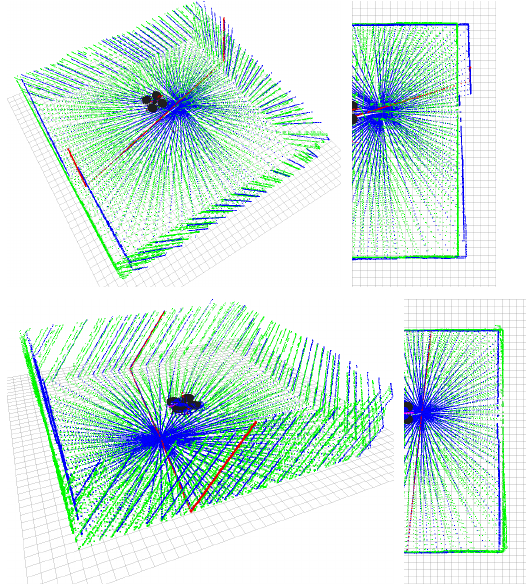
Figure 7: Sensor movement during scan acquisition yields dis- torted 3D scans (top). We deskew the scan based on the motion estimate (bottom).